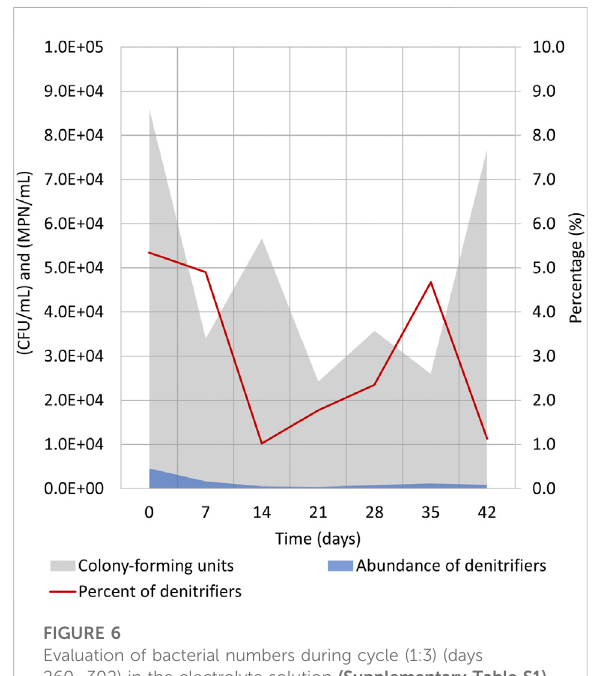
Evaluation of bacterial numbers during cycle (1:3) (days 260 – 302) in the electrolyte solution (Supplementary Table S1) . Heterotrophic culturable microorganisms were enumerated by CFU/mL on nutrient agar, and heterotrophic denitrifying bacteria numbers were evaluated by MPN/mL in Hiltay medium (see chapter 2.4 for